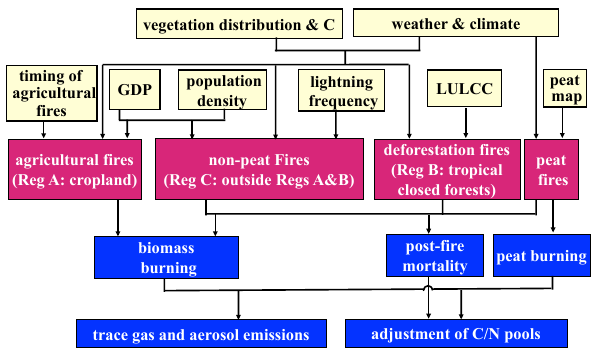
Fig. 2. Structure of new fire parameterization. Fire scheme de- scribed in Li et al. (2012a, b) is used in Region C with modifica- tions by mainly adding the economic influence in the fire occur- rence component and the socioeconomic influence in the fire spread component. Table 2. Plant functional types (PFTs) used in the present study.